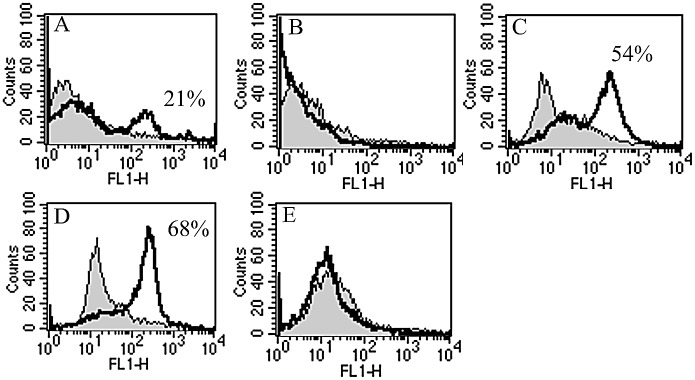
Representative histogram plots show CD3 expression levels measured by FACS.The percentage shift in CD3-FITC fluorescence (overlaid as a black line) was calculated relative to isotype controls (coloured grey). The histogram peaks are typically broad due to the population being of mixed cell type. CD3 expression levels before T-cell depletion of BMNC (Tw) show a mature T-lymphocyte population of 21% (A). Complete depletion of CD3+ cells was observed in T-cell depleted (Td) fractions on day 0 (B). A new T-cell subpopulation, accounting for 54% of Td sample, was produced by day 12 (C). Td T-cell proportion was increased over 10 days of long-term culture to reach 68% on day 25 (D). No CD3+ cells were observed in Td, Tp or Tw populations cultured in the absence of stimulatory factors PHA and IL-2. Td data only shown in (E).